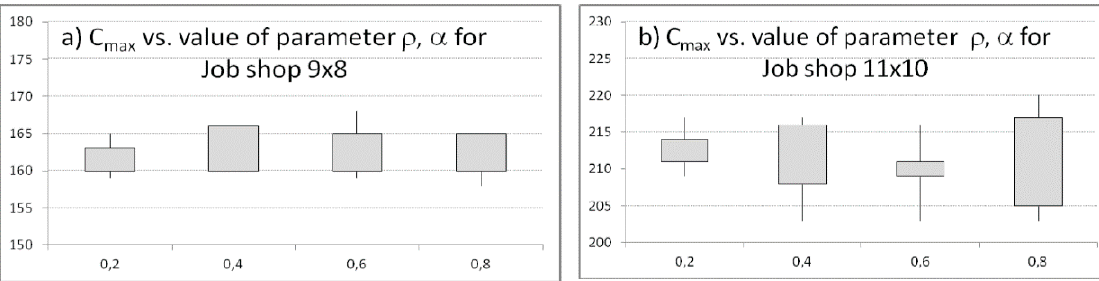
achieved (Figure 5) the following conclusion can be drawn that the higher values of ρα= pheromone evaporation factors are, the higer chances of achieving a better so- lution are. Algthough the average quality of population does not increase with the pa- rameter values, better solutions are achieved for scheduling problem (9 × 8). The best scheduel is achieved for C max equals 152 for scheduling problem (9 × 8), for the phero- ρα= mone evaporation factor = 0.8 (Figure 5a). The best scheduel is achieved for C max equals 203 for scheduling problem (11 × 10), for the pheromone evaporation factor ρα= = {0.4, 0.6, 0.8} (Figure 5b). Figure 4. The C max of the basic schedules achieved by the ACO for different size of ant population. Then, the simulations are continued for the number of ants, K = {15}, iteration size, E = {20}, parameter q 0 = 0.5 and changing values of pheromone evaporation factor { } .8.0,6.0,4.0,2.0 == ρα Observing average values of C max and the best schedules